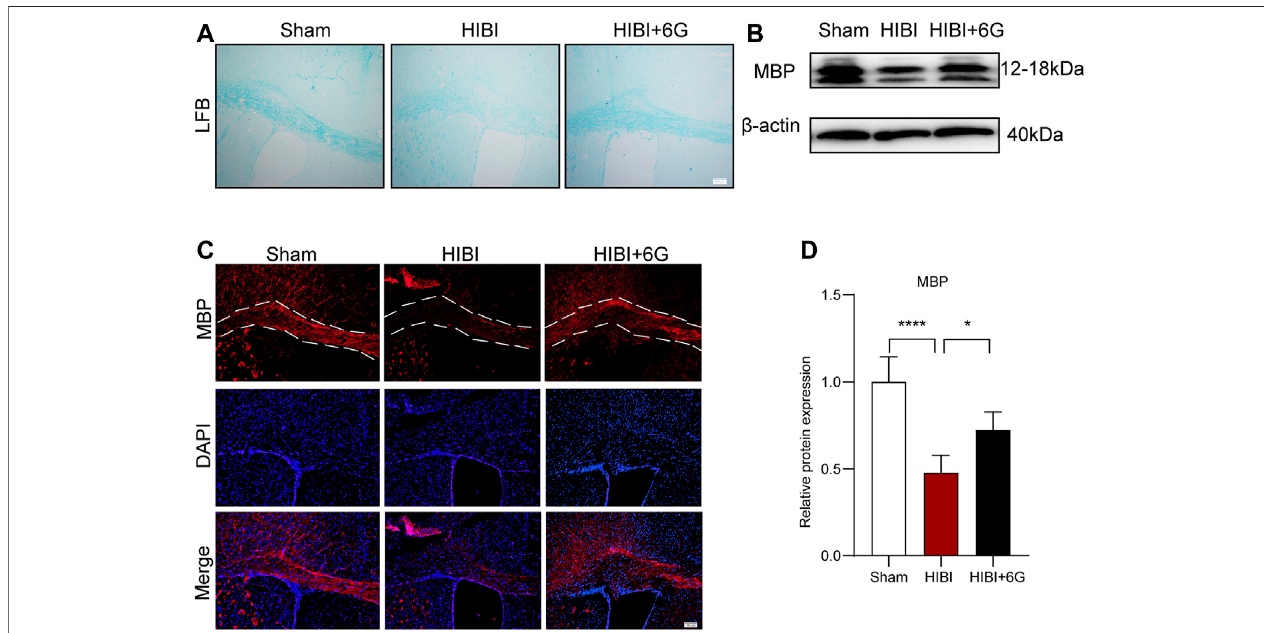
FIGURE 5 | 6-Gingerol inhibits HIBI-induced loss of myelin at 4-week post-HIBI. (A) Representative Luxol Fast Blue staining of the callosum at 4-week post-HIBI. (B) Representative myelin basic protein (MBP) staining of the callosum at 4-week post-HIBI. (C – D) Representative western blot images and quanti fi cation of MBP expression of the callosum at 4-weeks post-HIBI. n (cid:1) 5 per group. The area marked with dashed lines represents the corpus callosum. Scale bar (cid:1) 100 μ m. Data represent the mean ± SEM. * p < 0.05, ** p < 0.01, *** p < 0.001, **** p < 0.0001.